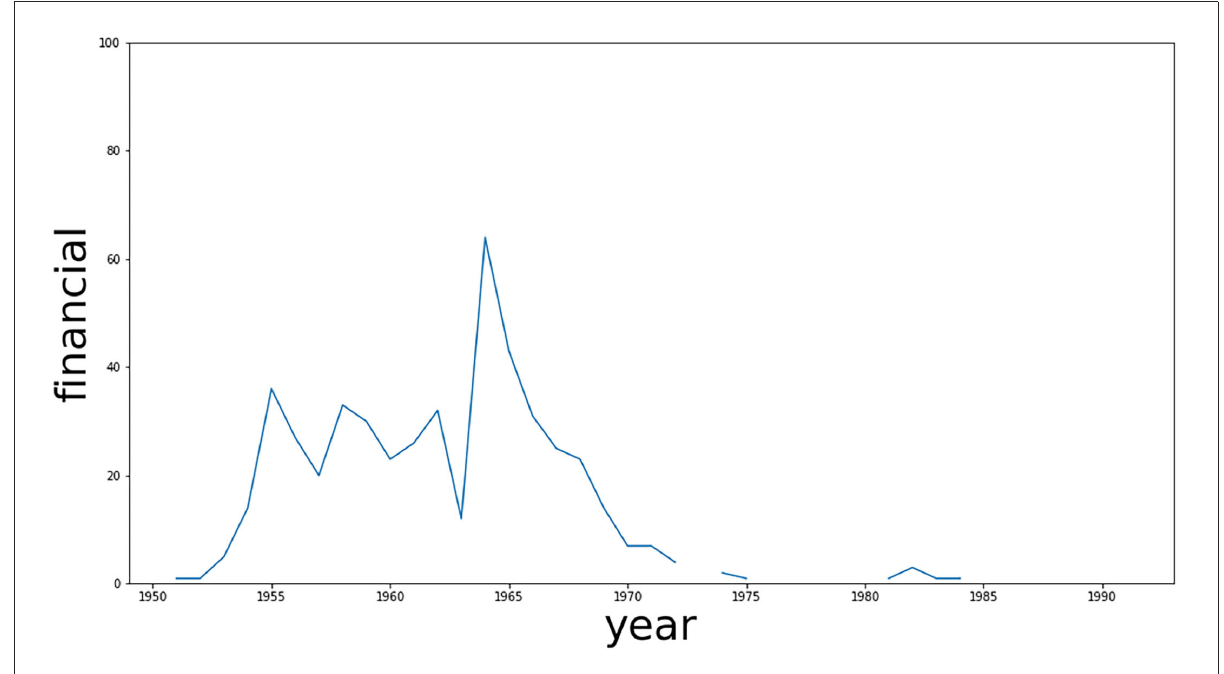
FIGURE7 Financial events/year—(source—emigrant registration